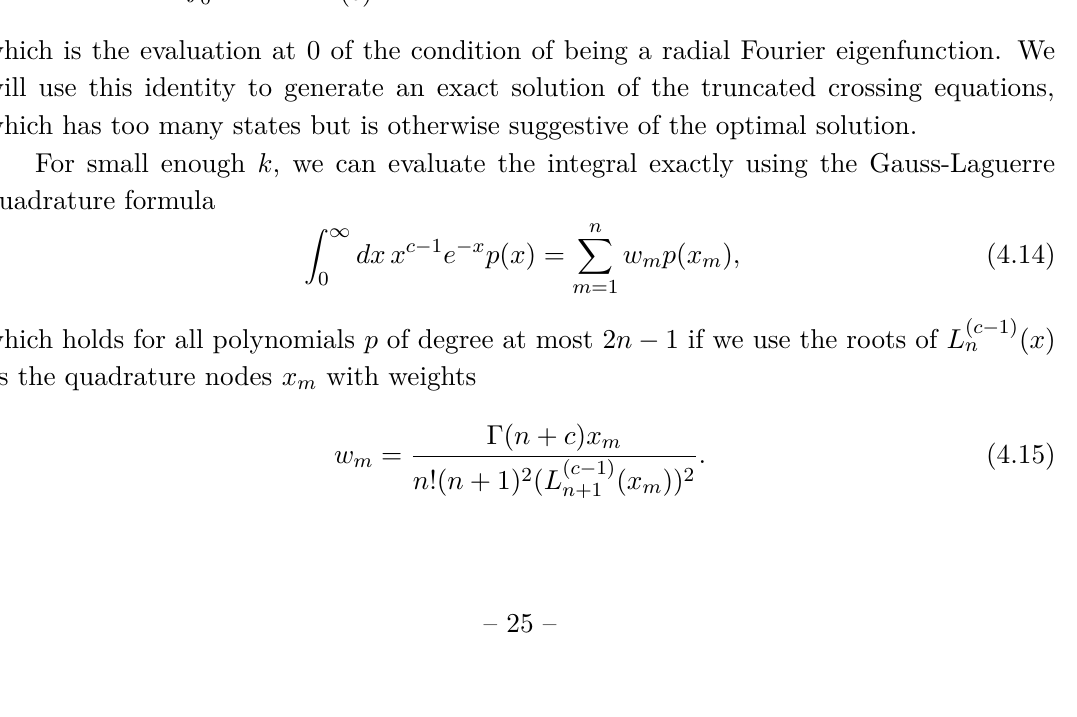
Figure 13 . The gaps log (green), and c = 20